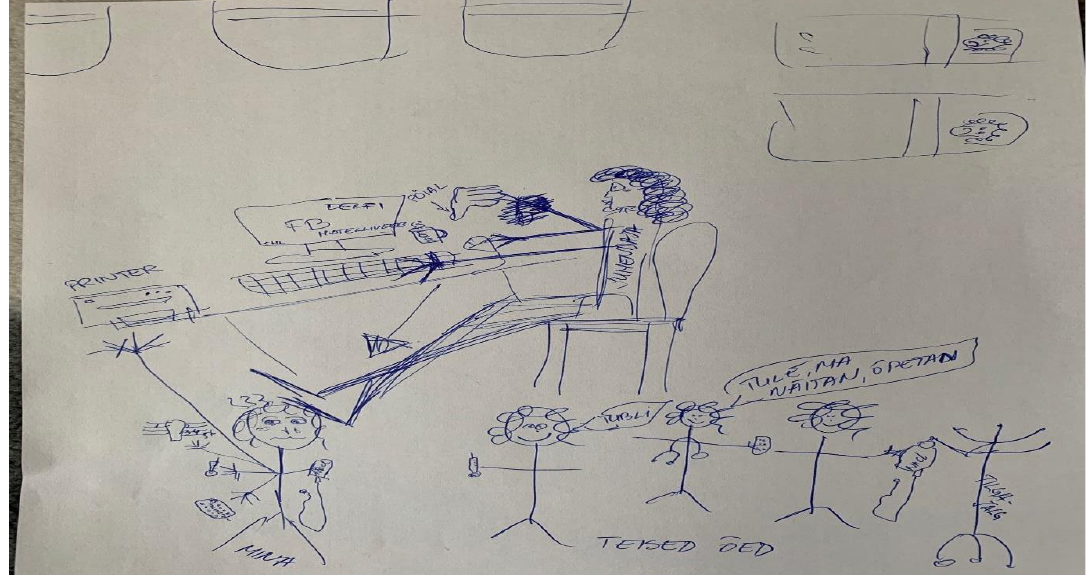
Illustration 3 . Nurse students’ visualisation: "How I was trained in